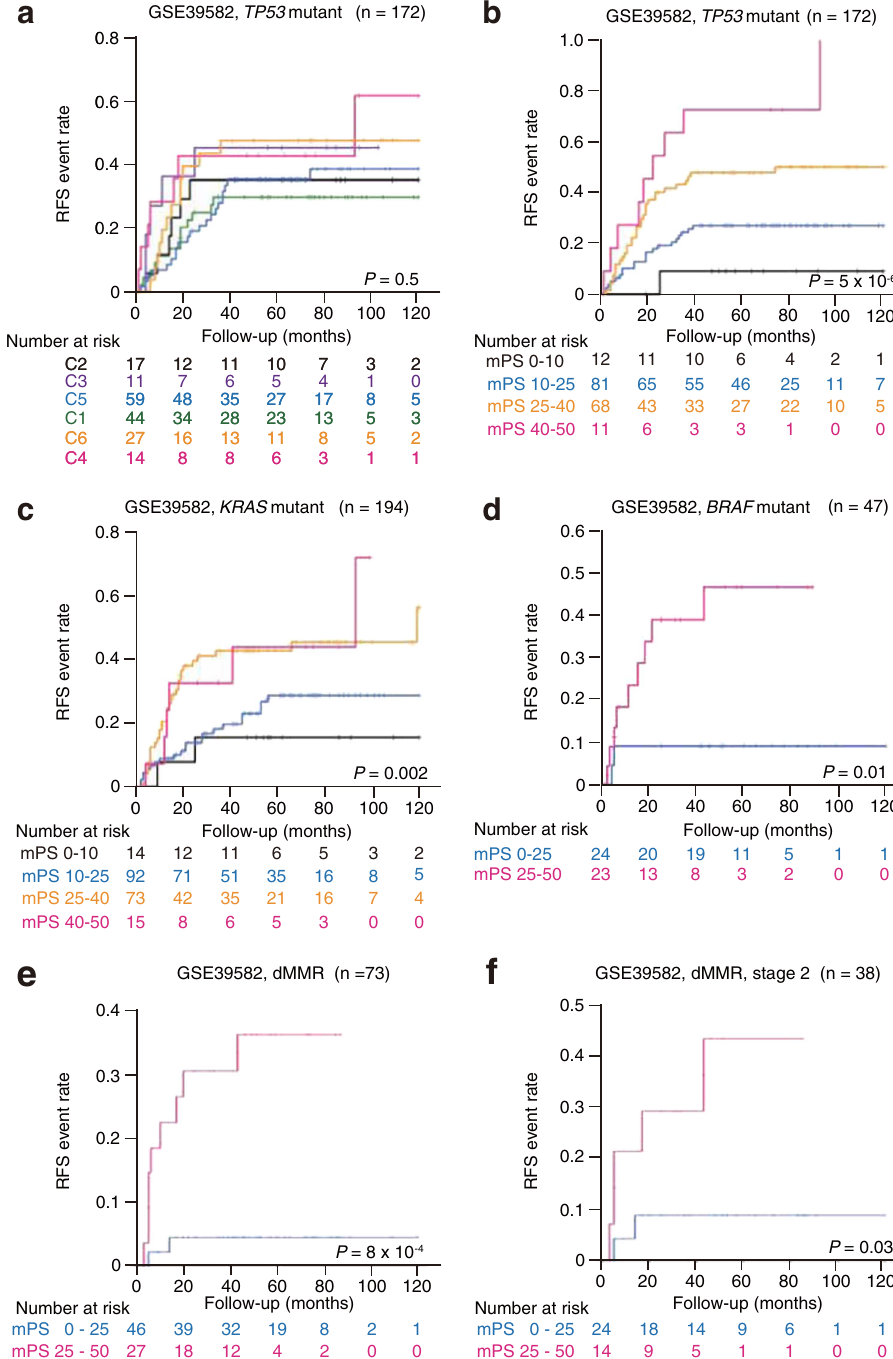
Fig. 2 mPS_colon strati fi es colorectal cancer patients in the GSE39582 cohort regardless of molecular status. a Kaplan – Meier curve of relapse-free survival (RFS) for TP53 mutation-positive patients in the GSE39582 cohort on the basis of molecular subtypes de fi ned previously 11 . The log-rank P value is shown. b – f Kaplan – Meier curves of RFS according to mPS_colon for patients harboring TP53 ( b ), KRAS ( c ), or BRAF ( d ) mutations as well as for those with mismatch repair-de fi cient (dMMR) tumors ( e ) or those with dMMR tumors at stage 2 ( f ). The log-rank P values are shown. Only patients with available information are